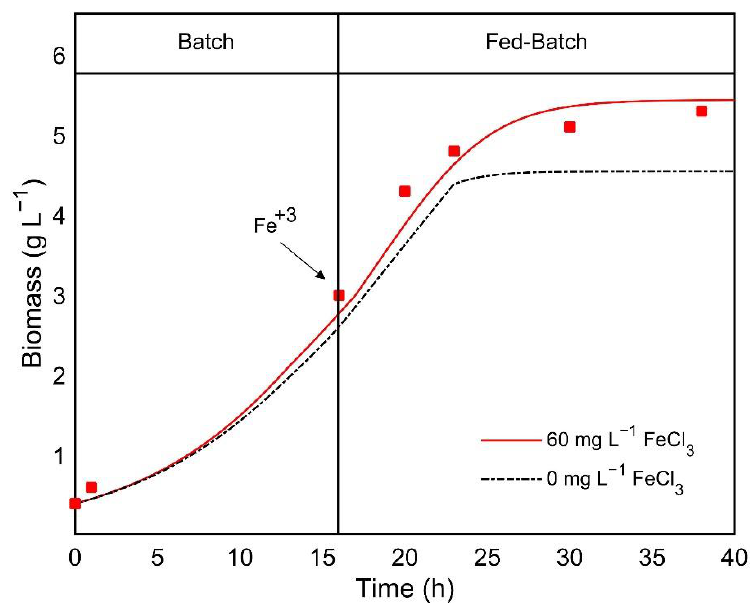
Figure 4. Effect of iron supplementation after 15 h on biomass formation using a feeding profile (glucose) with an exponential stepwise increased flow under heterotrophic fed-batch cultivation of C. sorokiniana . The red line and squares represent simulated and experimental data, respectively. The Black dotted line represents simulated data for a non-iron supplemented culture with the same feeding profile.